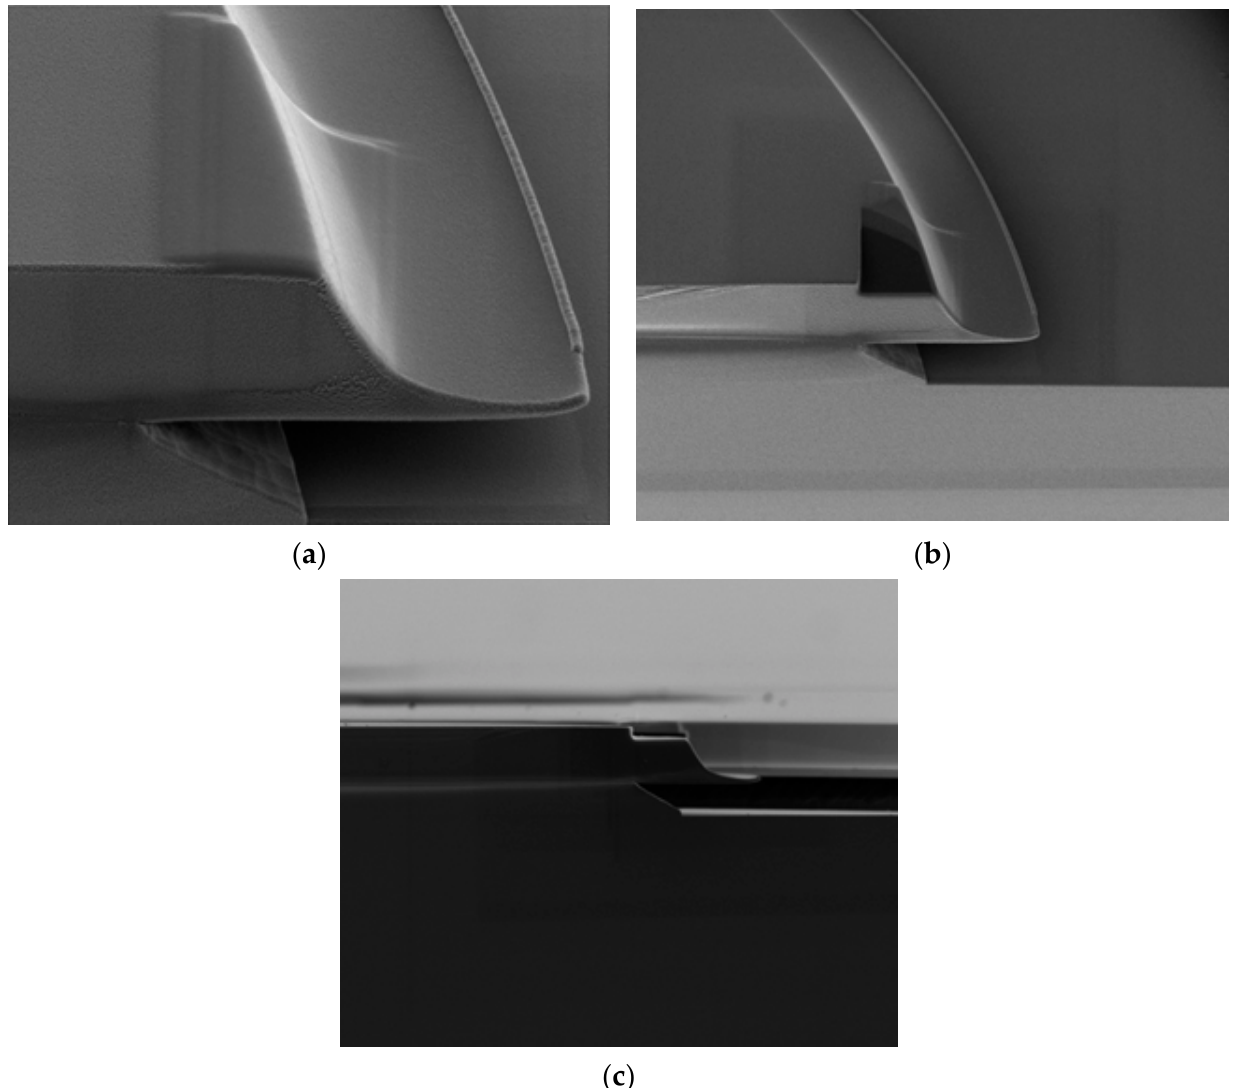
Figure 3. SEM images of the studied area: ( a ) chromium and platinum deposition performed; ( b ) the area removed by an ion beam; ( c ) side view of the studied area.